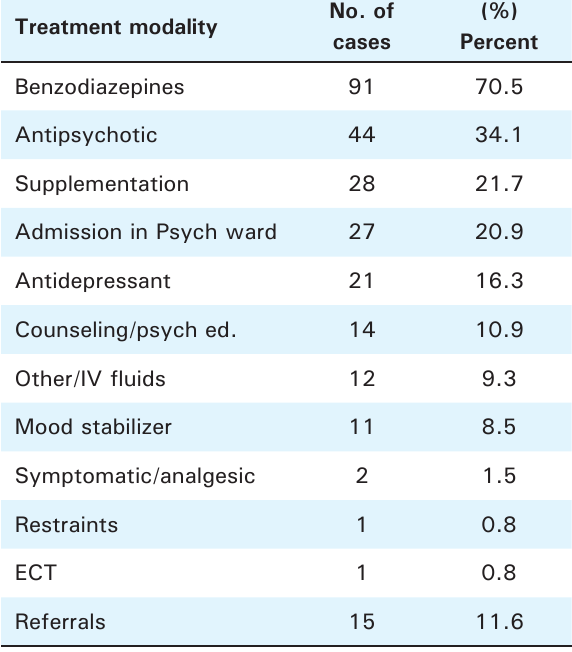
Table 4. Management of the